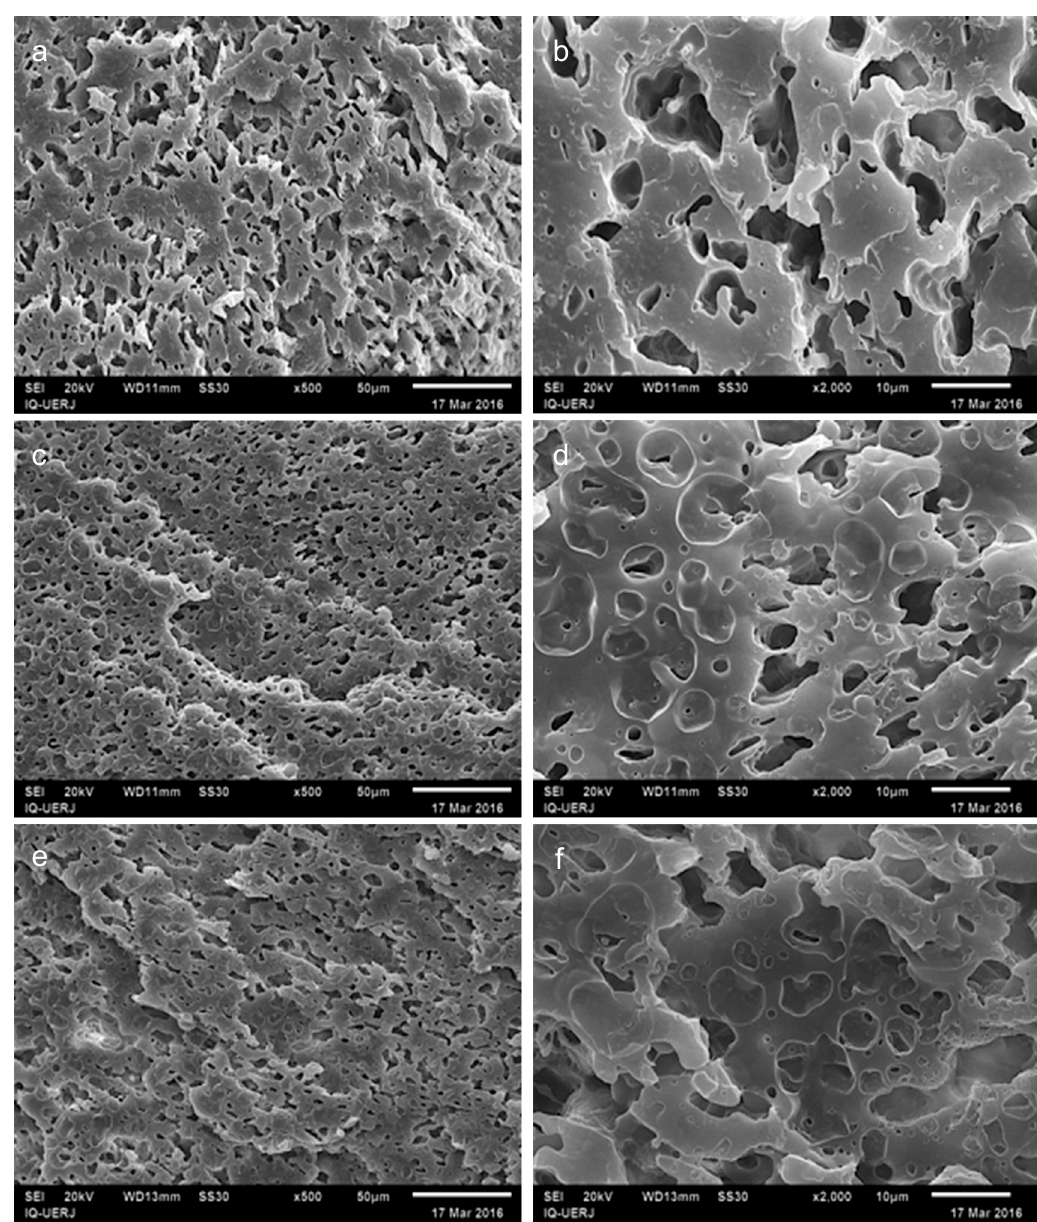
Figure 5. SEM micrographs of 3:2 PP/HIPS blends, after chloroform extraction: ( a , b ) without CNSL; ( c , d ) with 2.5 phr of CNSL; ( e , f ) with 5.0 phr of CNSL; images on left side, magnification of 500×; images on right side magnification of 2000×.